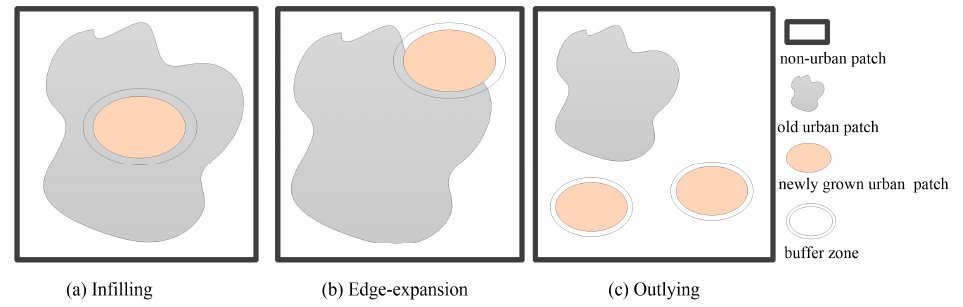
Figure 2. The three urban growth types (infilling, outlying, and edge-expansion).